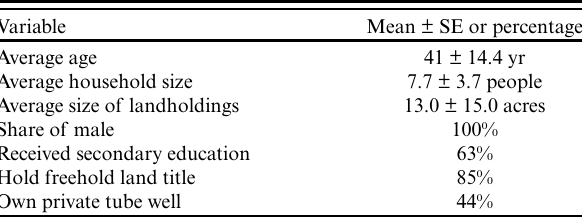
Table 1. Socioeconomic attributes of the sample population.